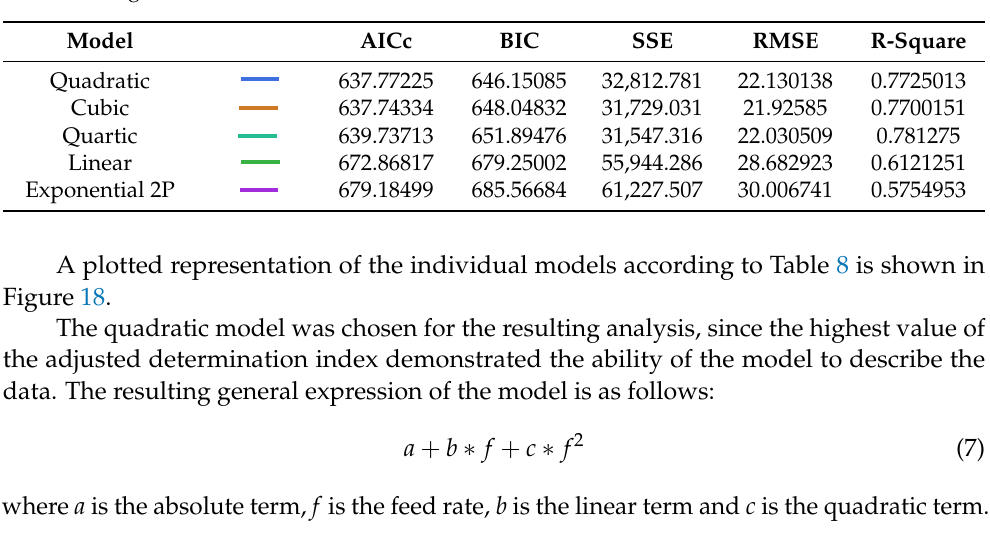
Figure 18. Plotted representation of individual models for examining the dependence of the number of holes drilled up to the moment of tool damage on the feed rate. The quadratic model was chosen for the resulting analysis, since the highest value of the adjusted determination index demonstrated the ability of the model to describe the data. The resulting general expression of the model is as follows: + ∗ + ∗ (7) where a is the absolute term, f is the feed rate, b is the linear term and c is the quadratic term. The numerical values of the individual terms are given in Table 9, which lists the basic parameters of the quadratic model of the dependence of the number of holes drilled up to the moment of tool damage on the feed rate. Table 9. Basic parameters of the quadratic model of the dependence of the number of drilled holes up to the moment of tool damage on the feed rate. Parameter